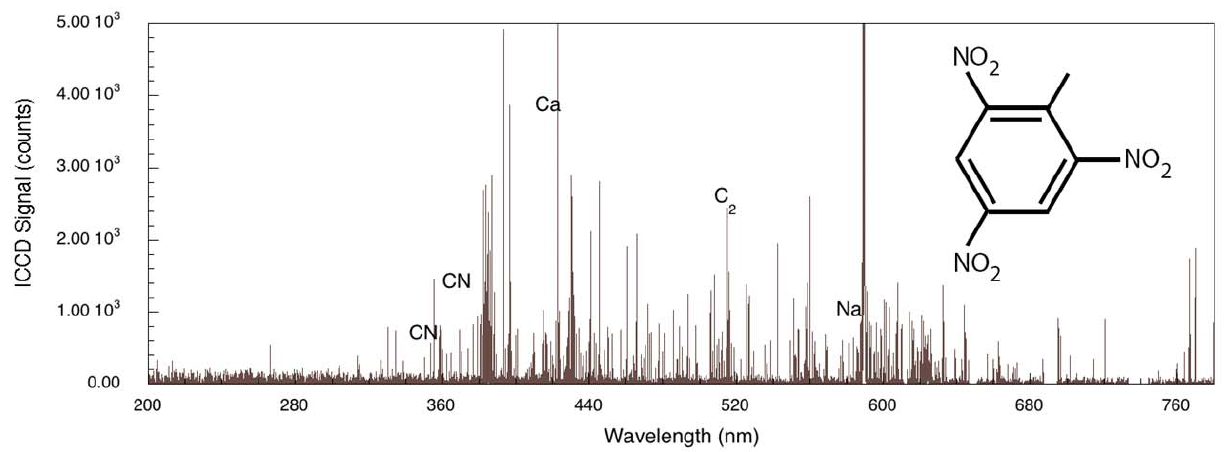
Figure 6. Femtosecond LIBS spectrum of TNT on polyoxymethylene with a carbon filler.